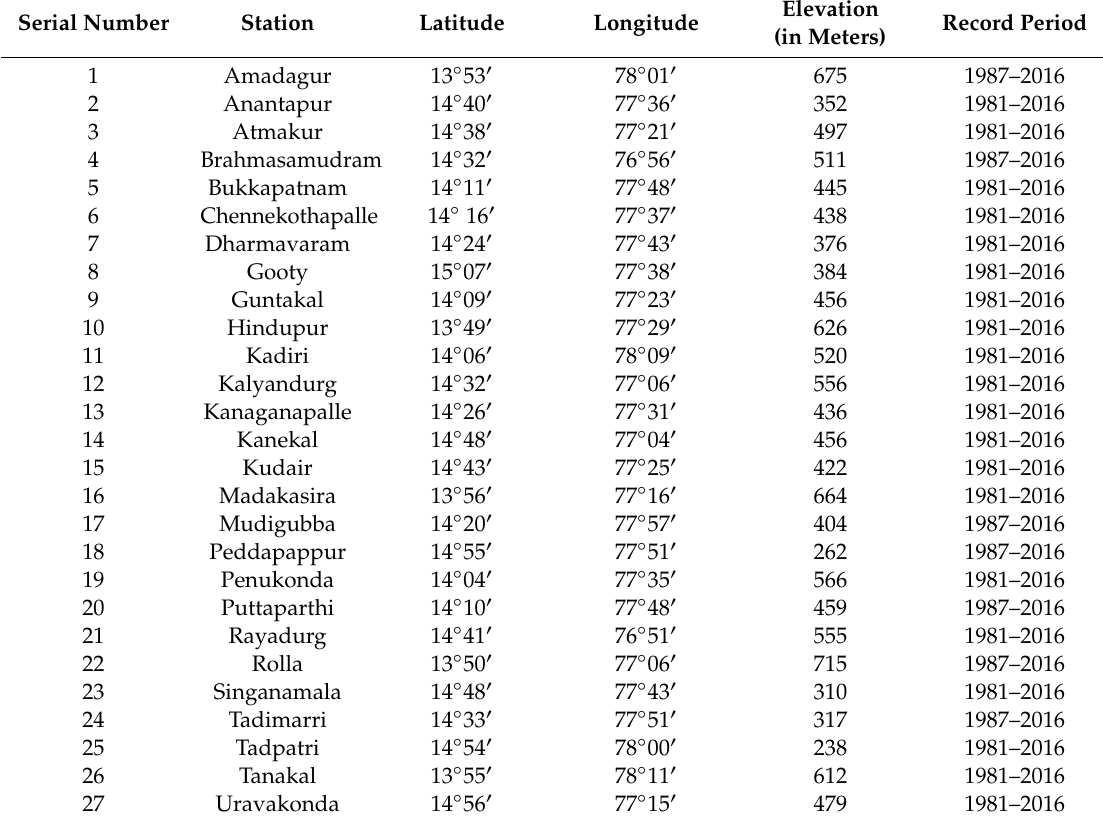
Table 1. Description of rain gauge locations in the study area considered for